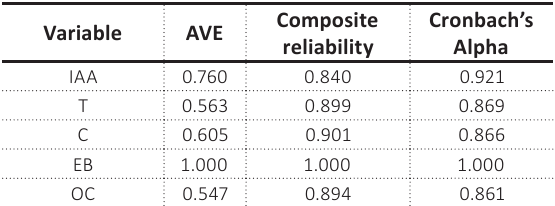
Table 2. Convergent validity and reliability